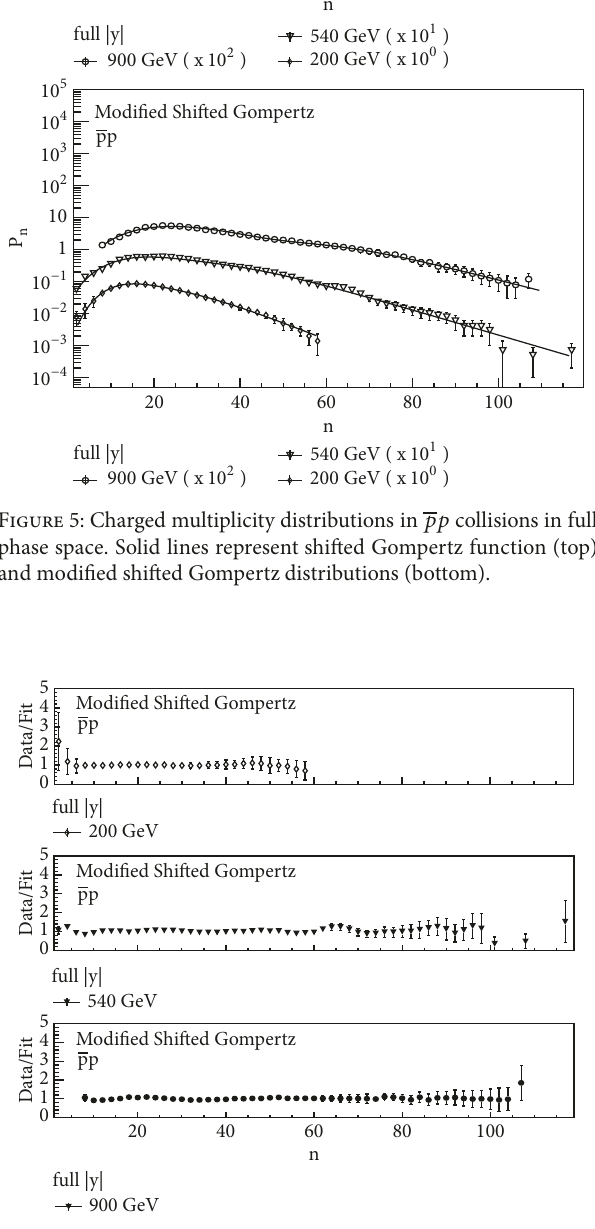
estimated 𝐾 = 0.35 ± 0.01 and 𝑛 0 = 2.2 ± 0.19. Under